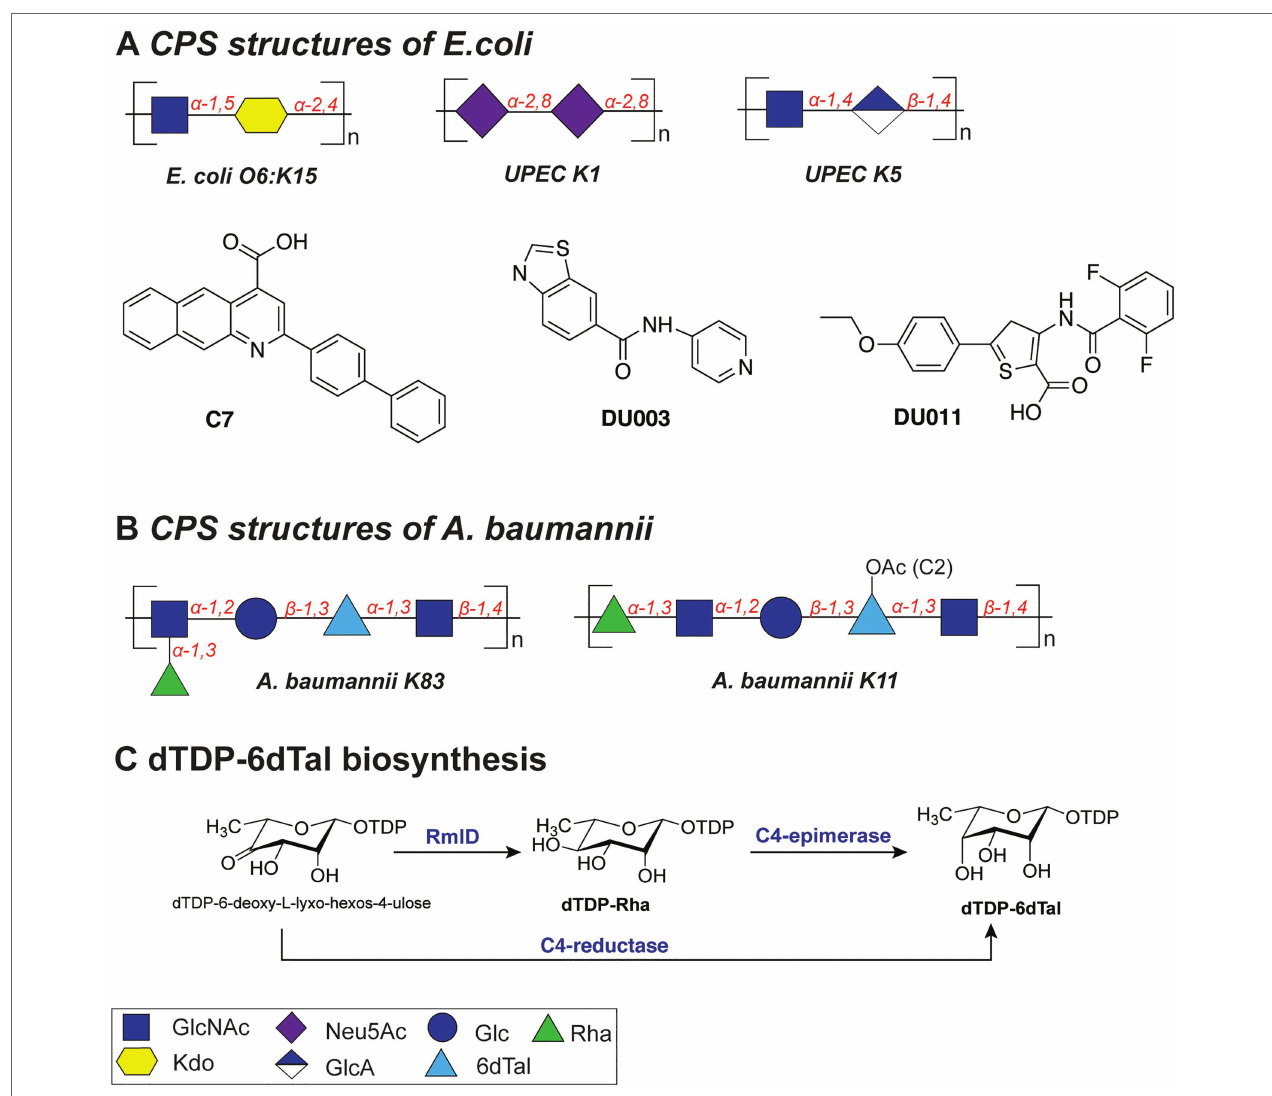
FIGURE 4 | (A) Structures of the capsular polysaccharides of Escherichia coli and inhibitors described in this section. (B) Structures of the capsular polysaccharides of Acinetobacter baumannii . (C) Biosynthesis of